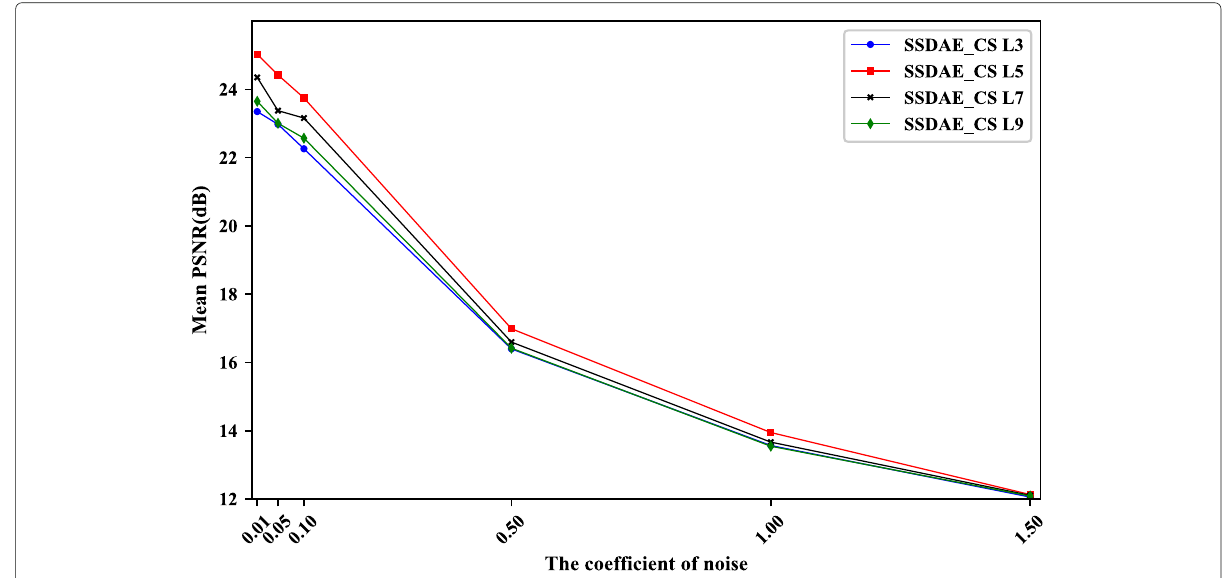
Fig. 8 The mean PSNR for different coefficient in the testing dataset when M =